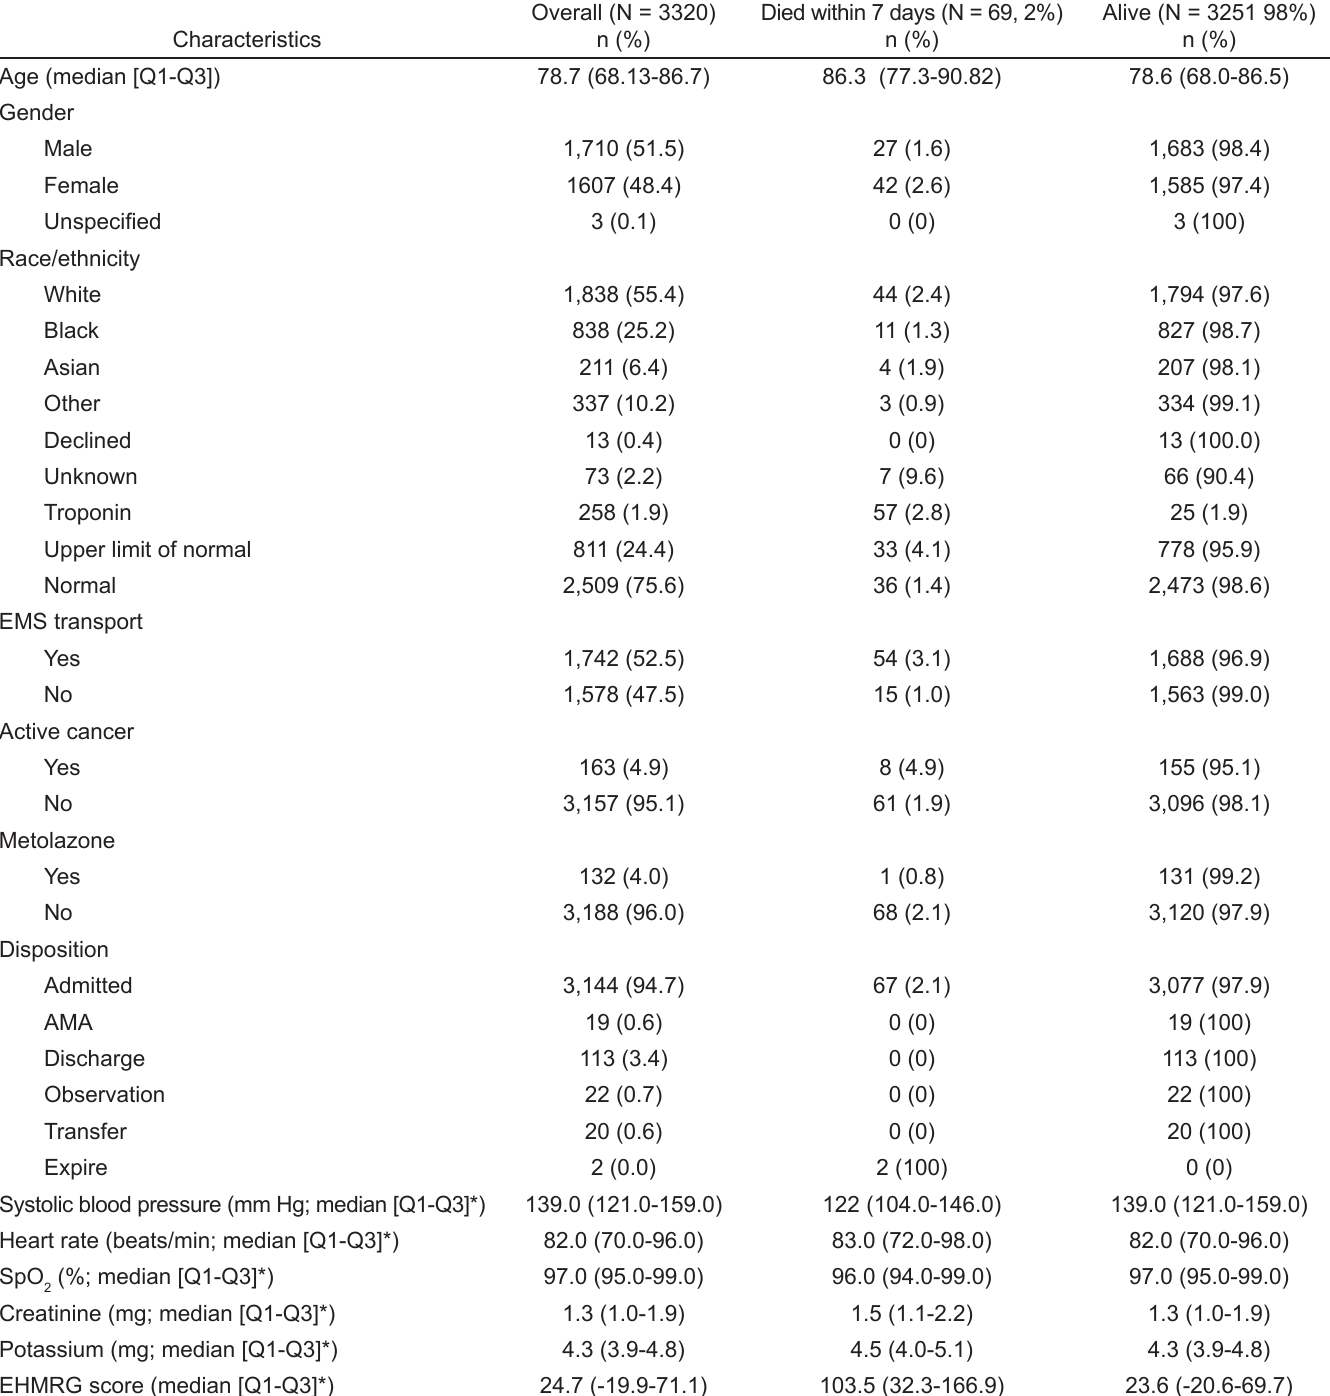
Table 1. Patient characteristics, overall and stratified by